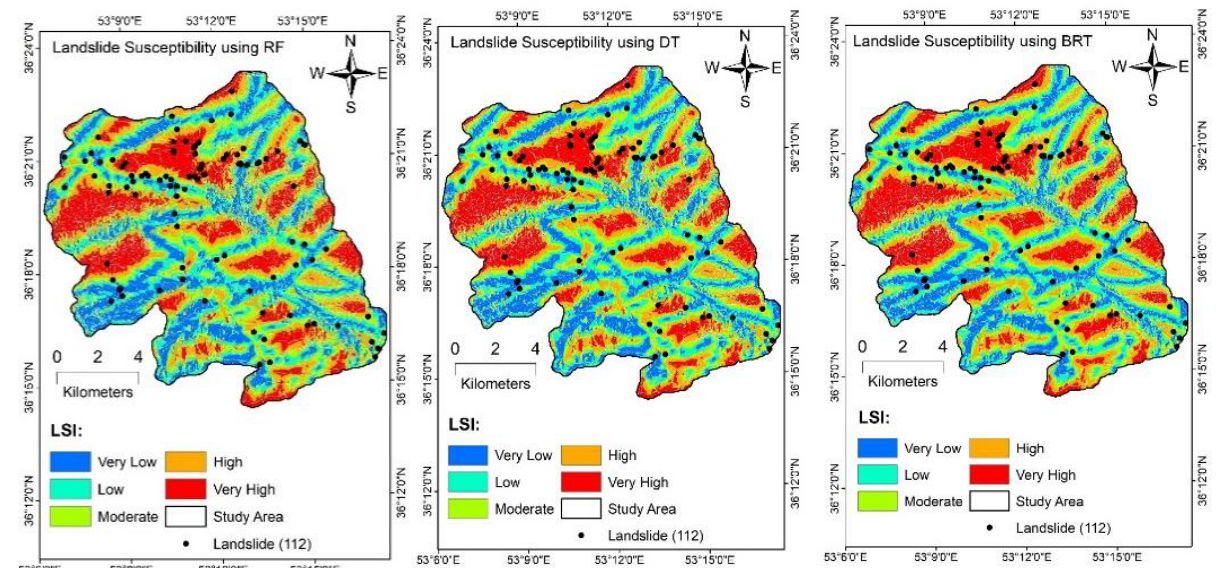
Figure 5: Landslide susceptibility maps produced by the RF, DT, and BRT.